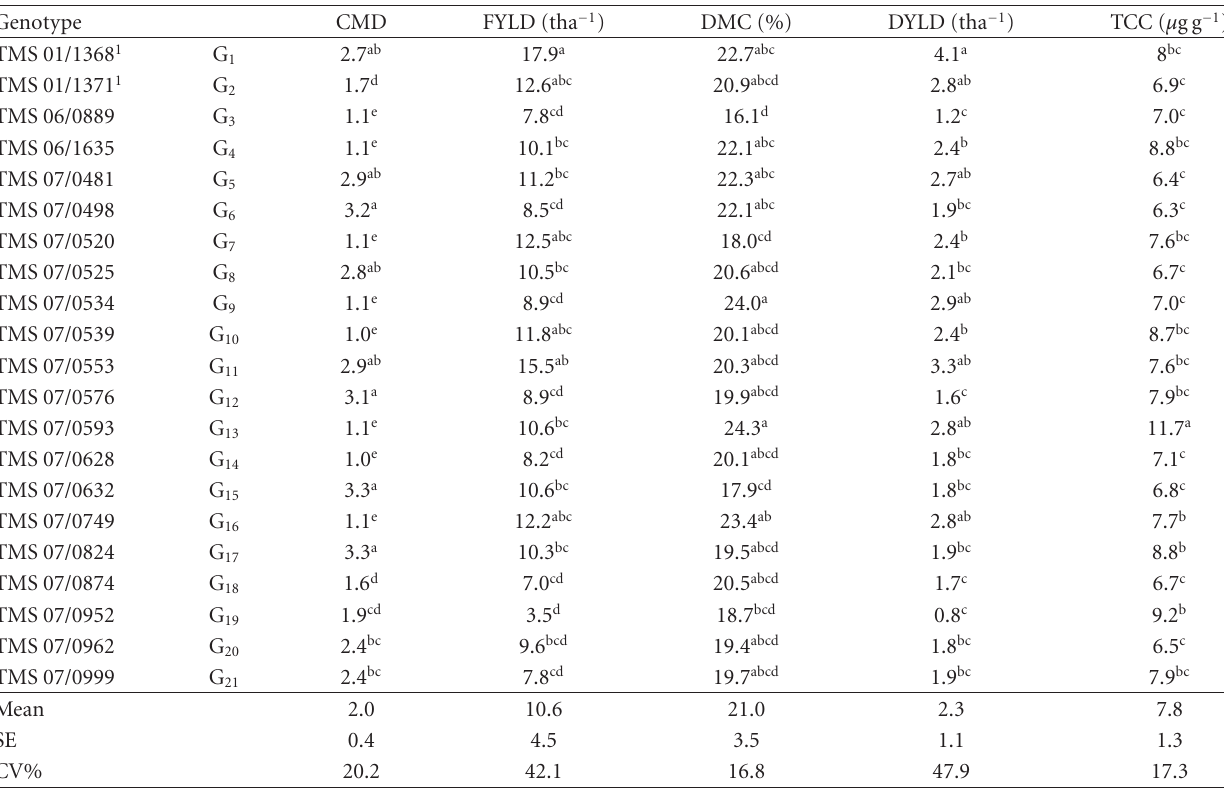
Table 1: Average CMD severity score, fresh root yield (tha − 1 ), root dry matter content (%), root dry yield (tha − 1 ), and total carotene concentration ( μ gg − 1 ) of 21 yellow-fleshed cassava genotypes in 10 environments.